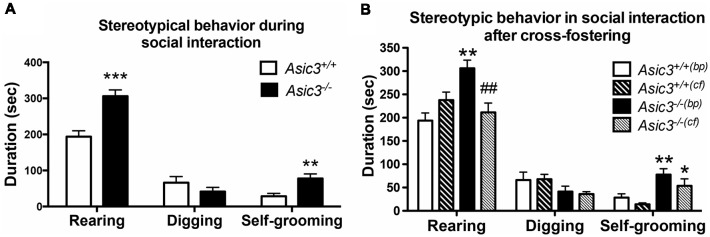
Increased self-grooming behavior during social interaction in Asic3−/− mice. (A)
Asic3−/− mice displayed higher self-grooming and rearing behavior during juvenile social interaction compared to Asic3+/+ mice. Rearing: t = 4.699, df = 18, p < 0.0002; Self-grooming: t = 3.286, df = 18, p < 0.0041. N = 10 mice per group. **p < 0.01; ***p < 0.001. (B) Cross-fostering the Asic3−/− mice to wild-type (WT) dam normalized the heightened rearing behavior in Asic3−/− mice during social interaction, but did not change the level of grooming behavior. bp, biological parents; cf, cross-fostering. Rearing: genotype: F(1,35) = 5.940, p = 0.020; Cross-fostering: F(1,35) = 2.065, p = 0.160; interaction: F(1,35) = 15.444, p < 0.001; Post hoc analysis: **p < 0.01 vs. Asic3+/+(bp), ##p < 0.01 vs. Asic3−/−(bp); Self-grooming behavior: genotype: F(1,35) = 18.001, p < 0.001; Cross-fostering: F(1,35) = 3.371, p = 0.075; interaction: F(1,35) = 0.212, p = 0.648; Post hoc analysis: **p < 0.01 vs. Asic3+/+(bp), *p < 0.05 vs. Asic3+/+(cf). N = 9–10 mice per group. Data represent mean ± SEM. Data analyzed by two-tailed unpaired t-test
(A) two-way analysis of variance (ANOVA; B).